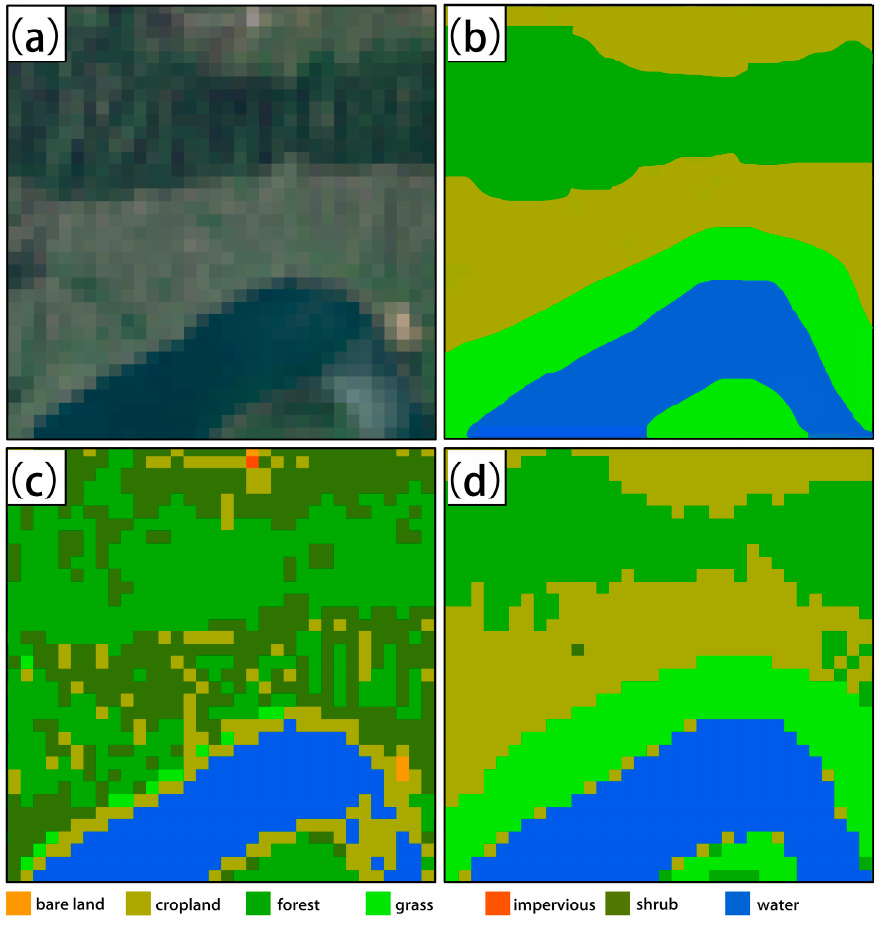
Figure 7. LULC classification of a representative region: ( a ) Landsat image in true color; ( b ) sample polygons based on expert knowledge; ( c ) SVM with spectral features only; ( d ) SVM + spectral features + all adjacent region features (S = 17).